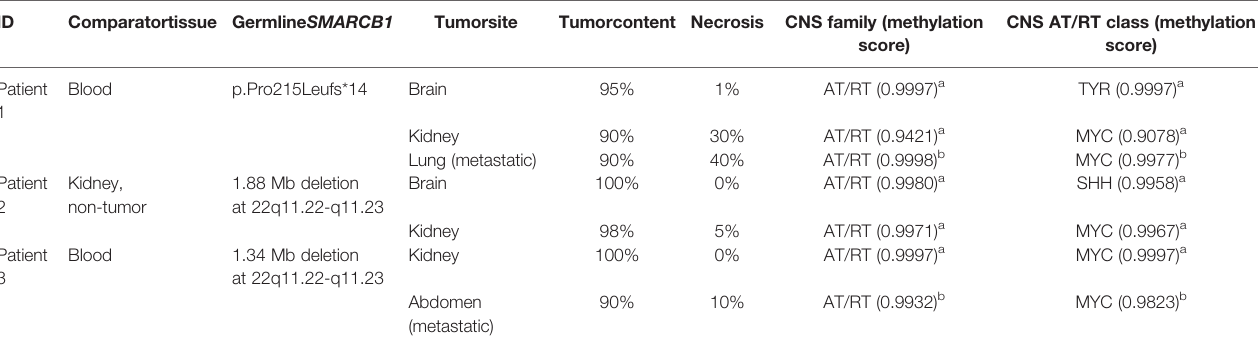
TABLE 1 | Summary of molecular fi